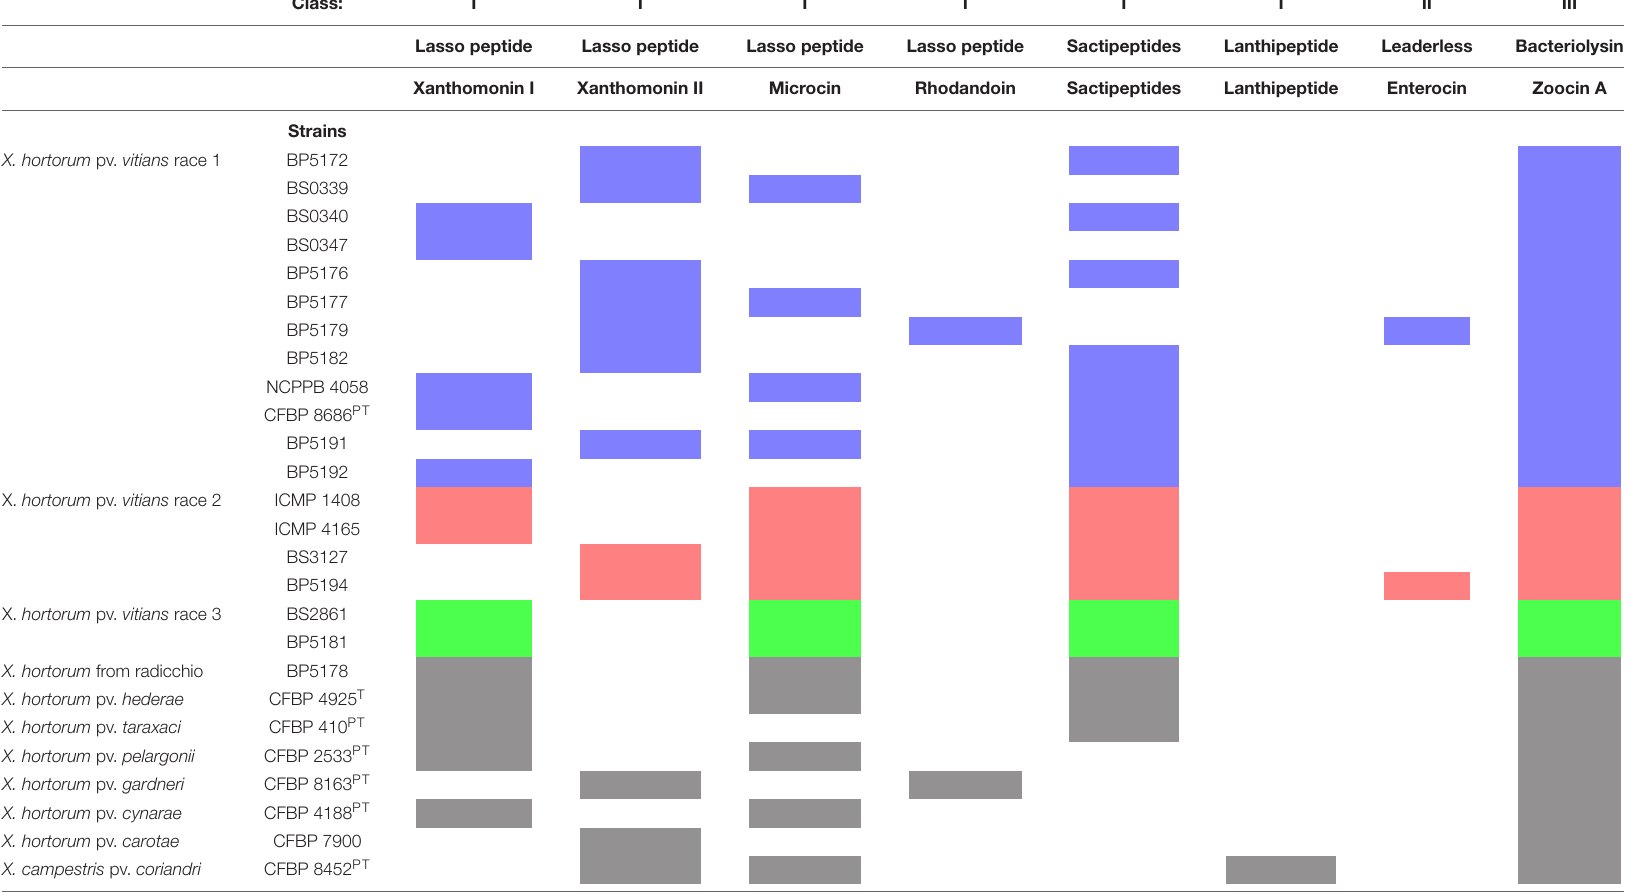
Solid color indicates predicted gene presence, no fill indicates predicted gene absence. Blue color corresponds to Xhv race 1 hits, red to Xhv race 2 hits, green to Xhv race 3 hits, and gray to related Xanthomonas reference strain